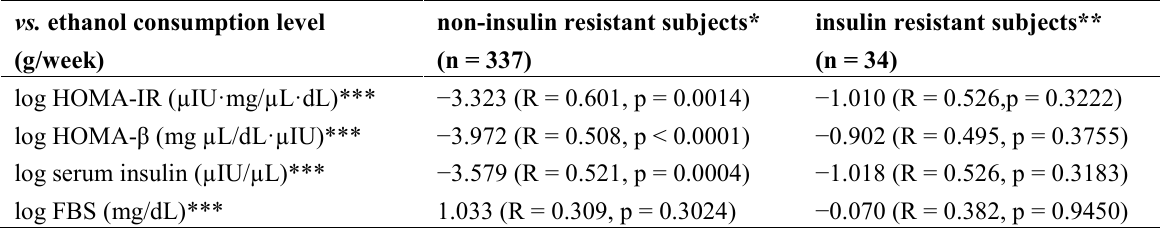
Table 4. Effects of HOMA-IR on relationship between levels of ethanol consumption and HOMA-IR, HOMA-β, insulin and FBS assessed by multiple regression analyses; t value (p